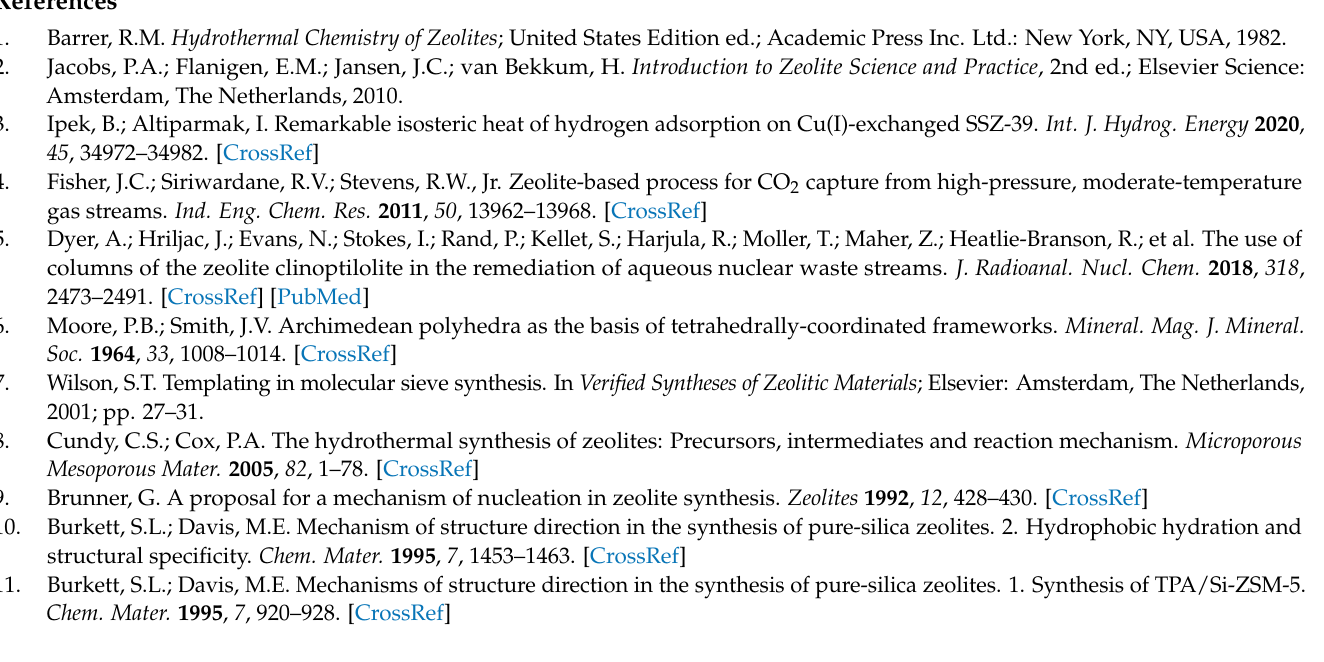
Figure S3: Final refined unit cell structure for the empty zeolite RHO sample; Figure S4: Final refined unit cell structure for the filled zeolite RHO sample; Figure S5: Final refined unit cell structure